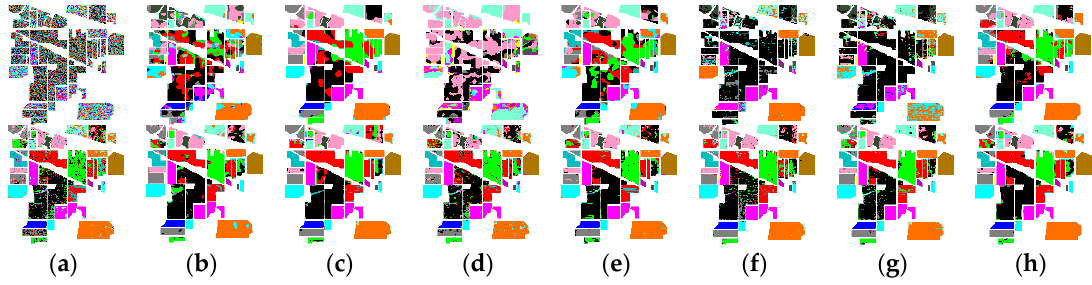
Figure 21. Classification results for Indian Pines data before and after denoising: the first row is the results of the 20 heavily corrupted bands; the second row presents the results of the remaining 200 bands: ( a ) Original HSI; ( b ) KSVD; ( c ) BM3D; ( d ) ANLM3D; ( e ) BM4D; ( f ) LRMR; ( g ) DDL3+FT; ( h ) Our method.